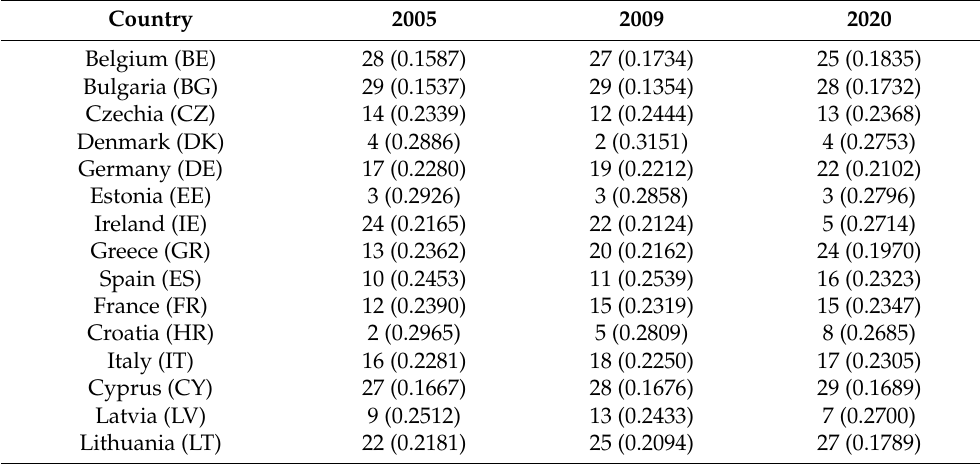
Table 1. Rankings and values of synthetic COPRAS measure (in parentheses) of European countries with respect to the degree of implementation of SDG7 in the years 2005, 2009, and 2020. Source: own